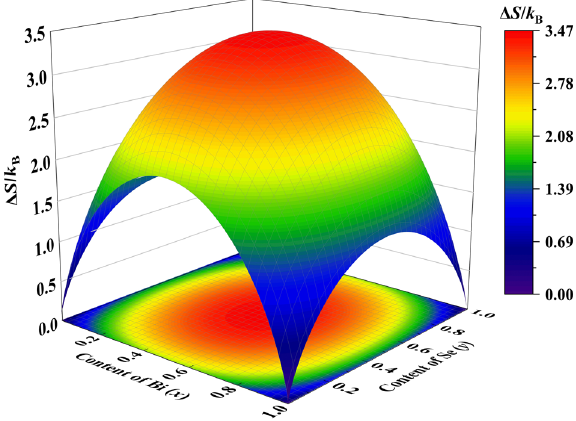
Fig. 2 Con fi gurational entropy. The calculated Δ S of the alloyed Þ ð Se Þ ð Bi as a function of x and y x Sb 1 (cid:2) x y Te 1 (cid:2) y 2 3